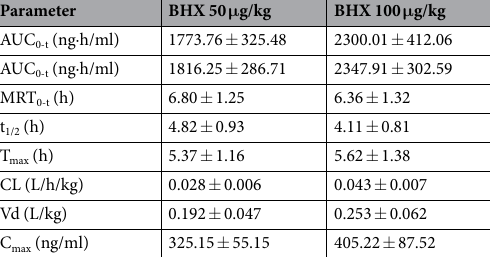
Table 1. In vivo pharmacokinetics of BHX in rats following intraperitoneal injection at doses of 50 and 100 μ g/ kg. Abbreviations: AUC, area under the concentration-time curve; MRT, mean residence time; t 1/2 , half-life; T max , time to maximum plasma concentration; CL, clearance; V d , volume of distribution; C max , maximum plasma